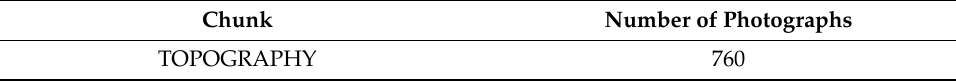
Table 3. Number of photographs taken for the generation of point clouds of topography. Chunk